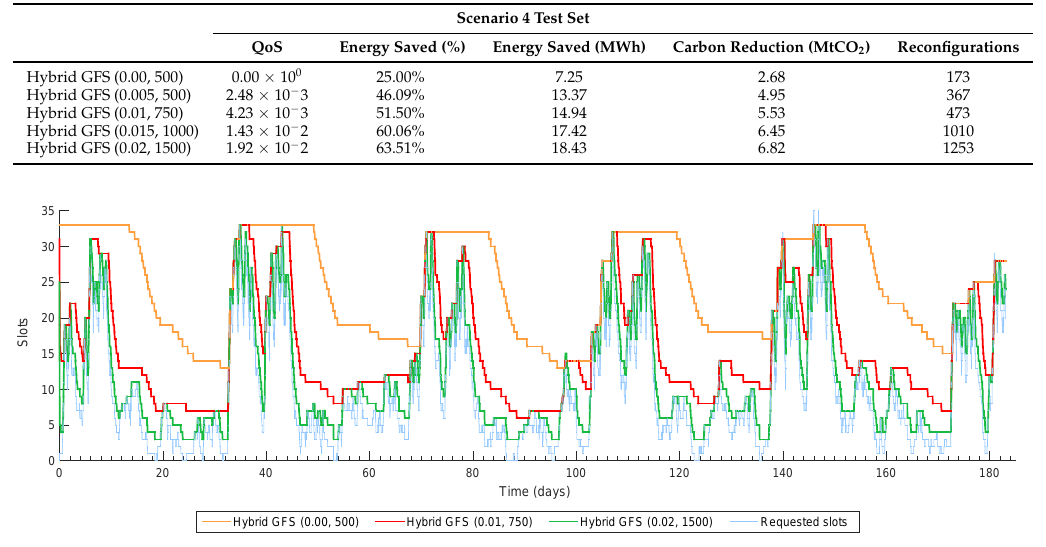
Figure 7. Cluster simulation trace for the test set of scenario 4. Table 6. Experiment results for the test set of the Scientific Modelling Cluster (CMS) workload